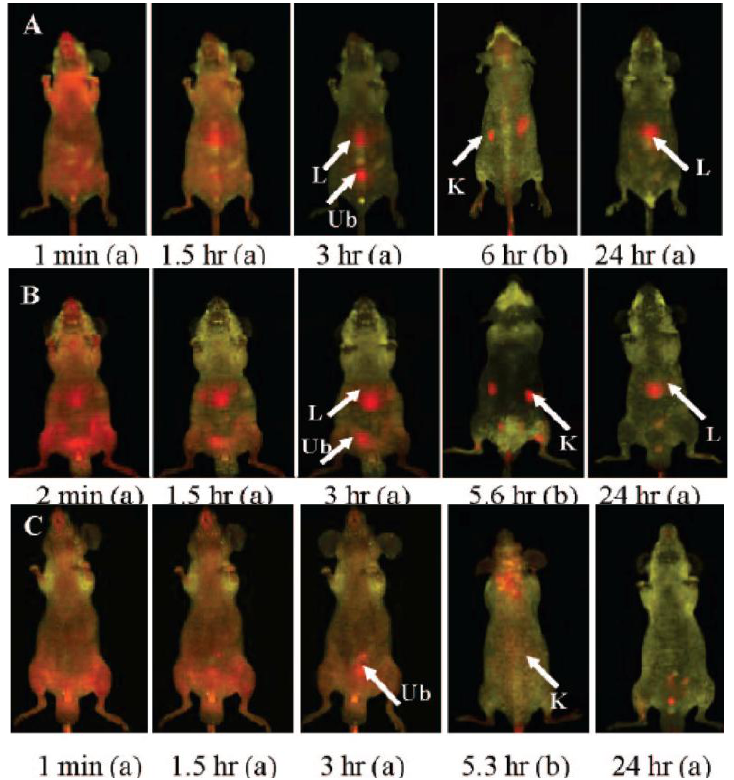
Figure 1. In vivo imaging biodistribution of different i.v. injected surface-modified SiNPs at different time points, postinjection ( A – C ; (a), abdomen imaging; (b), back imaging): (A) OH-SiNPs; (B) COOH-SiNPs; (C) PEG-SiNPs. Arrows mark the location of the kidney (K), liver (L), and urinary bladder (Ub). Reproduced with permission from [31] ® 2008, American Chemical Society.